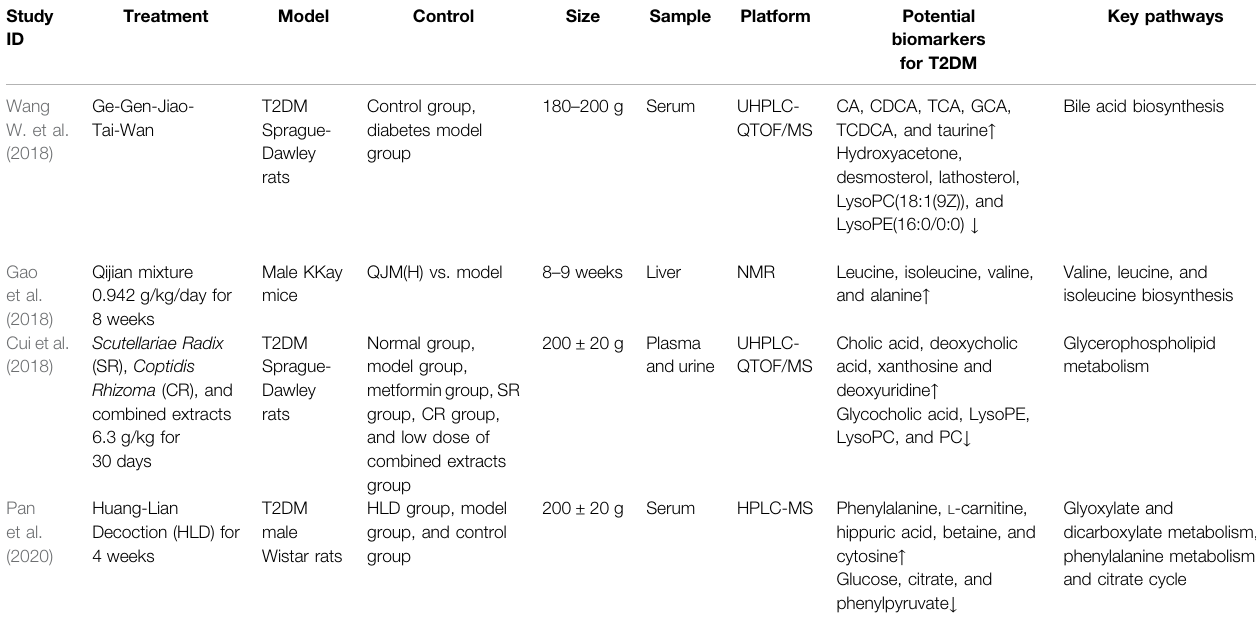
TABLE 1 | Information from metabolomics studies of TCM for lowering blood sugar in animal models. Study ID